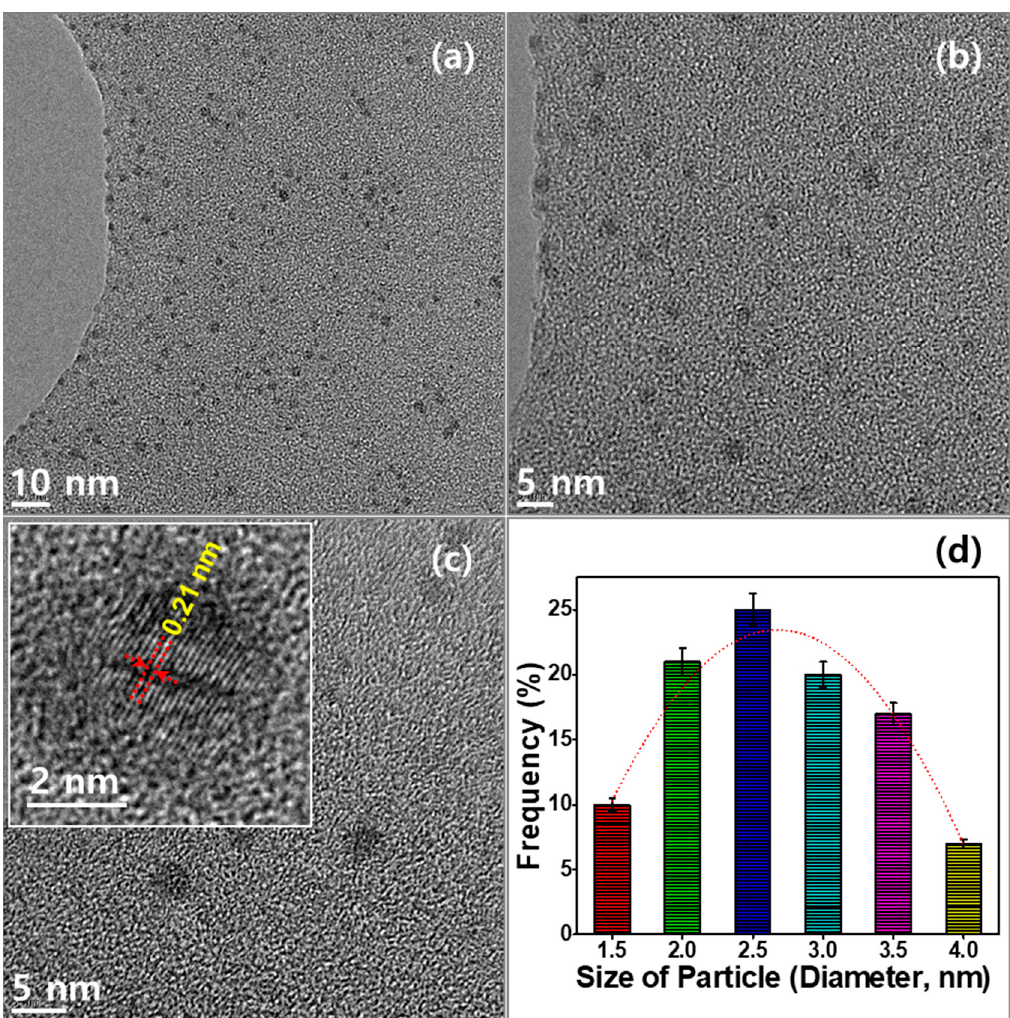
Figure 2. ( a – c ) HRTEM images of synthesized F-CNDs at different magnifications and ( d ) a particle size distribution histogram. size distribution